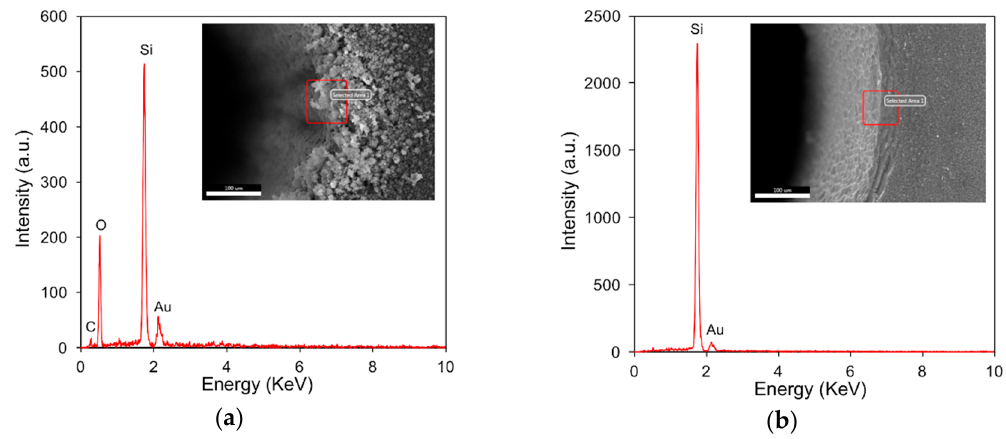
Figure 5. EDS (energy dispersive spectrometer) analysis results at given positions of the hole entrance edge marked by red squares, where ( a ) corresponds to direct laser machining, while ( b ) represents chemical-assisted trepanning. The processing parameters are same as those in Figure 4.